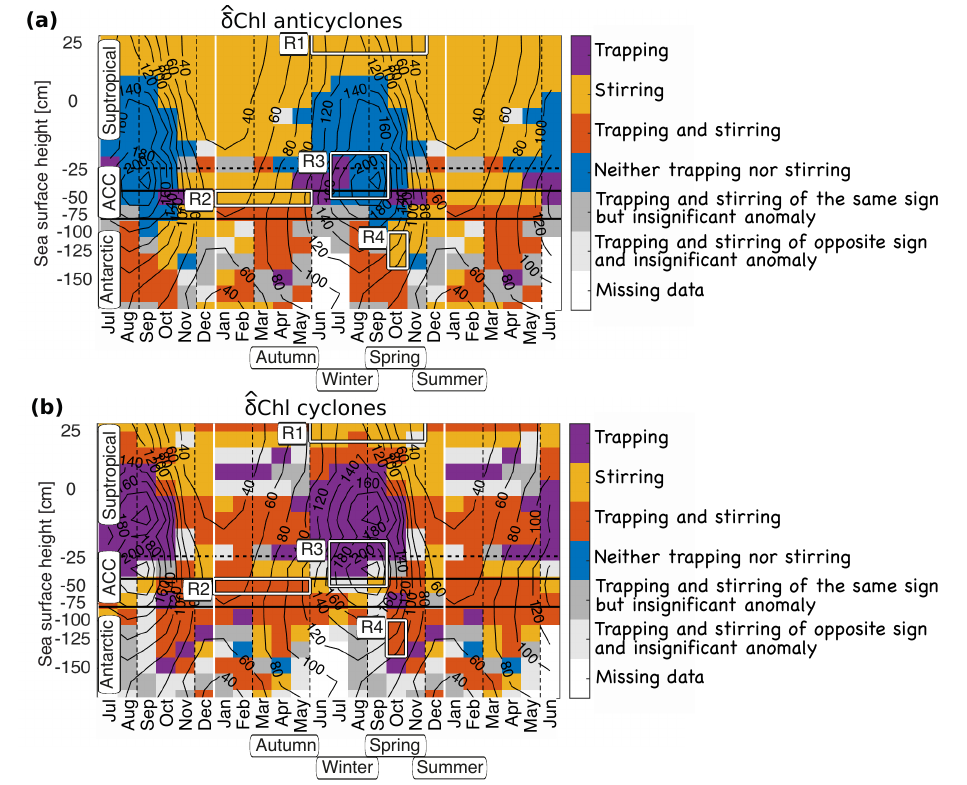
Figure 7. Hovmoeller diagram of the processes likely controlling the chlorophyll anomalies ( δ Chl) in (a) anticyclones and (b) cyclones: trapping (purple), stirring (yellow), a combination of the two (red) or neither of the two (blue), with the latter often interpreted to be the consequence of changes in the local growth or losses (biogeochemical rates). A region is colored if the sign of the potential effect is the same as the observed one, and if δ Chl is significant. See text for details. White boxes indicate regions R1 to R4 used for composite Figs. 5 and 6. The data were binned in monthly sea-surface height bins. Horizontal solid black lines mark the ACC, the horizontal dashed black line denotes the − 20cm SSH contour, the vertical dashed lines seasons; solid black contours show averaged mixed layer depths in meters; note that the seasonal cycle is shown repeatedly to highlight cyclic